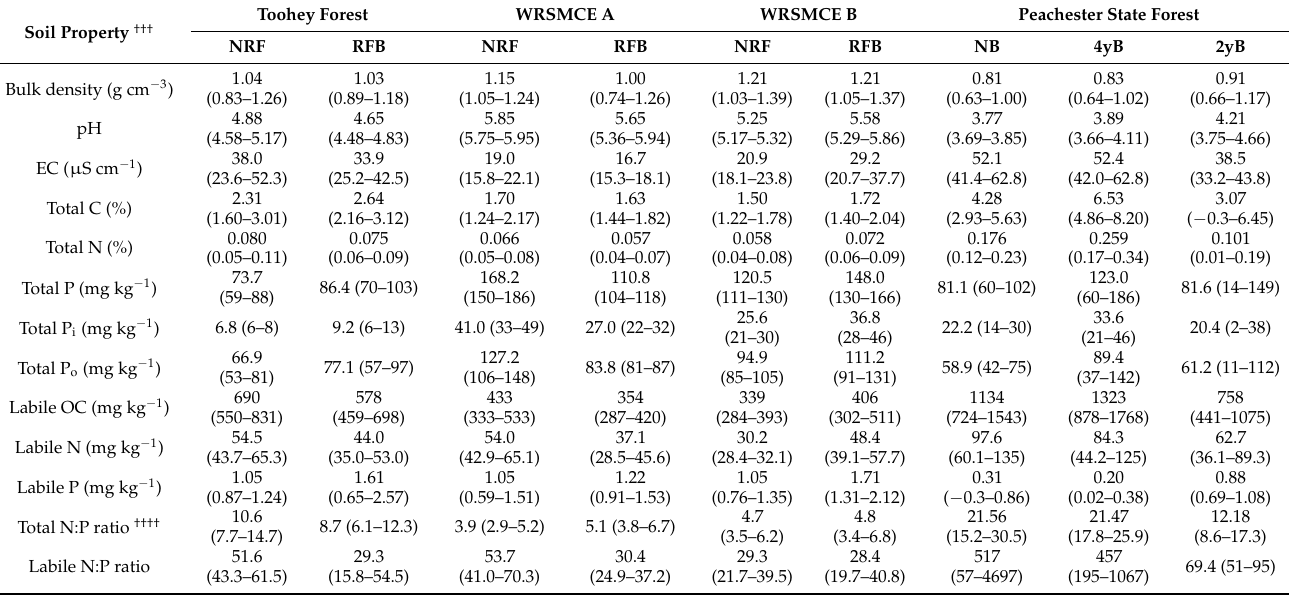
Table 3. Key surface soil properties (means ± 95% confidence intervals) at each of the study sites, contrasted between the different fire regimes † ( n = 5 for each fire regime at Toohey Forest, WRSMCE †† A, and WRSMCE B; n = 4 for each fire regime at Peachester State